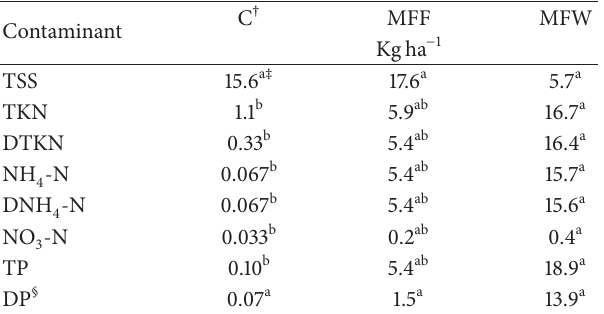
Figure 3: Total ammoniacal nitrogen (NH 4 -N), dissolved ammo- niacal nitrogen (DNH 4 -N), and nitrate nitrogen (NO 3 -N) loading in response to plant available nitrogen (PAN) application rate for C, LBF, and HBF. Table 5: Untransformed treatment means for all analyzed mineral fertilizer nutrients in runoff from Experiment 2 simulated rainfall plots. Note: values have been extrapolated to a kgha − 1